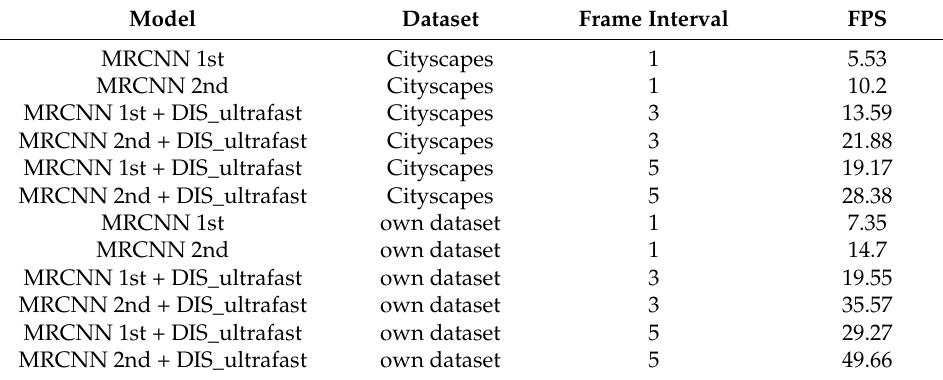
Table 5. Frame interval influence on time, RTX